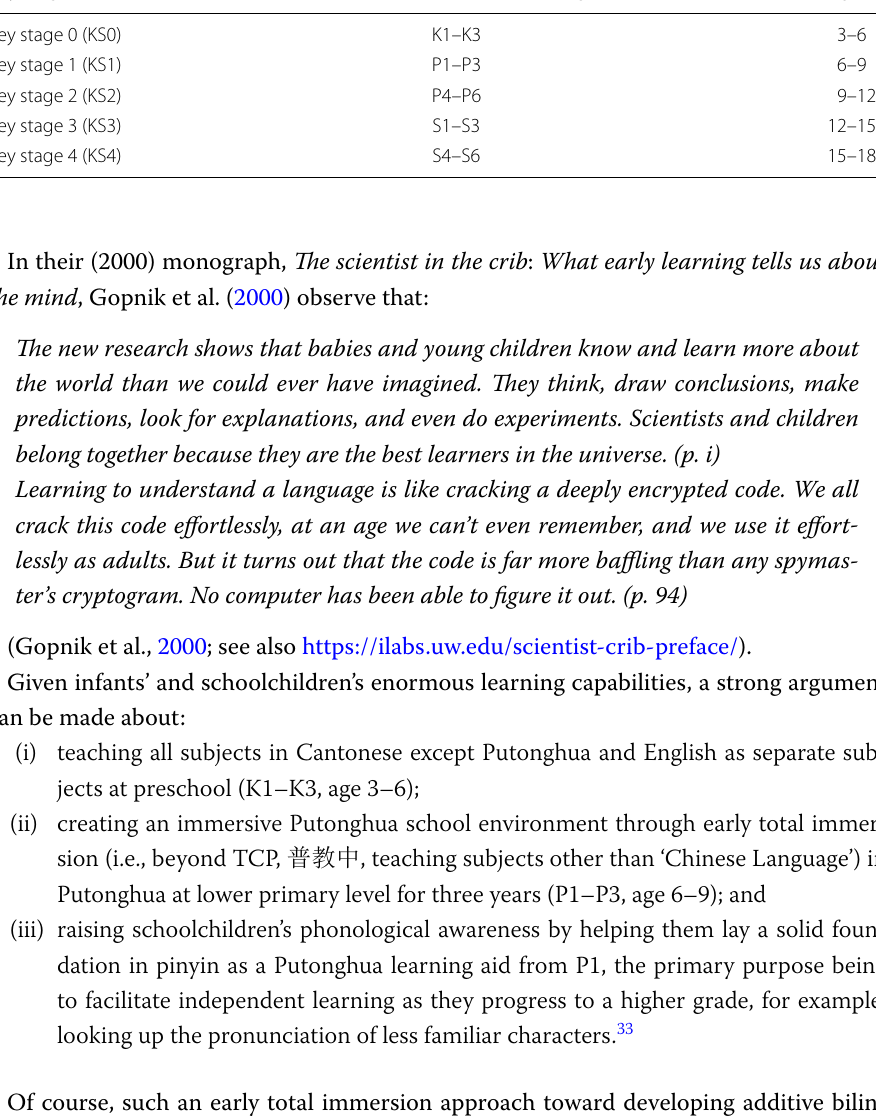
Table 2 Key stages of education, corresponding levels of schooling and age ranges Key